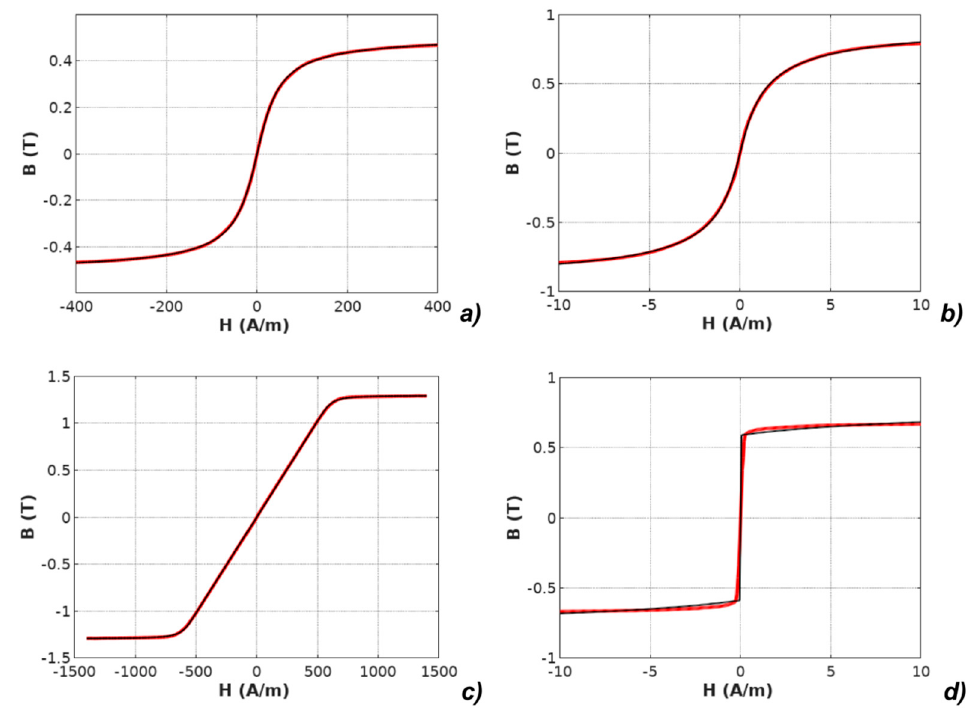
Figure 7. Results of modeling the anhysteretic curve using the anisotropic extension-based model (measurements: red line, modeling: black line): ( a ) Mn-Zn ferrite F3001, ( b ) Co 67 Fe 4 Mo 1 B 11 Si 17 amorphous alloy, ( c ) Fe 73.5 Cu 1 Nb 3 Si 15.5 B 7 nanocrystalline alloy with perpendicular anisotropy, ( d )